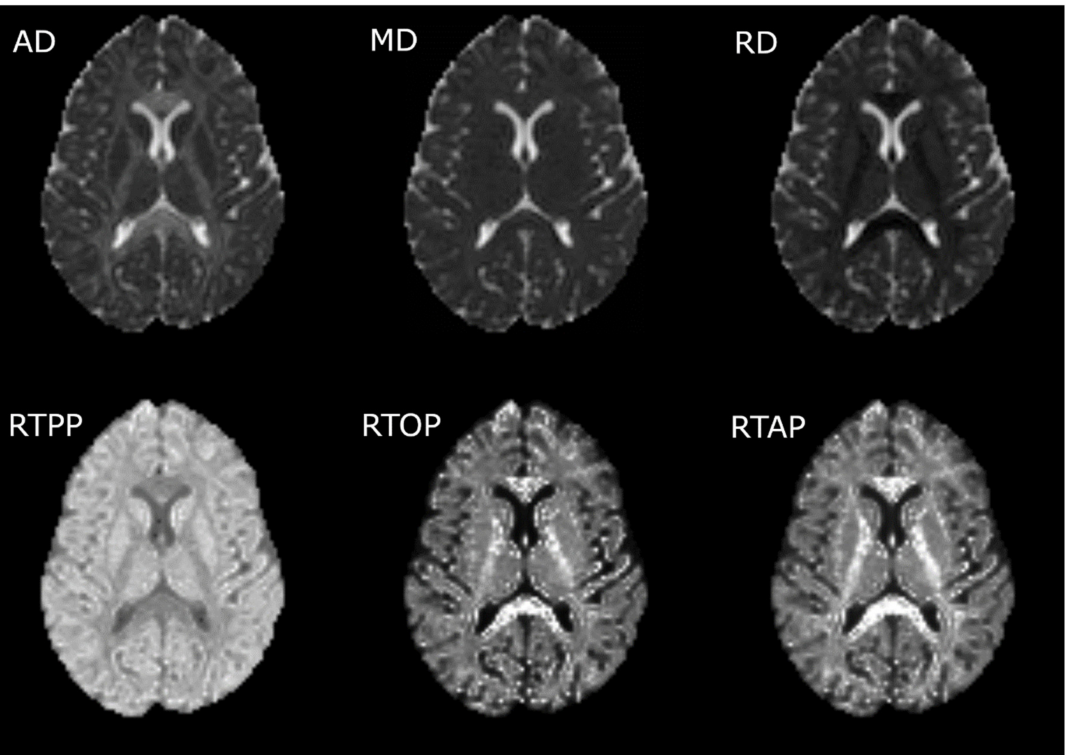
Figure 1. Visual comparison of di ff usion tensor imaging (DTI) and measures from apparent measures using reduced acquisitions (AMURA). The first row contains the DTI measures, and the second row the AMURA metrics. It is worth noting that the brightest regions for the DTI measures correspond to the darkest regions for the AMURA metrics, and vice